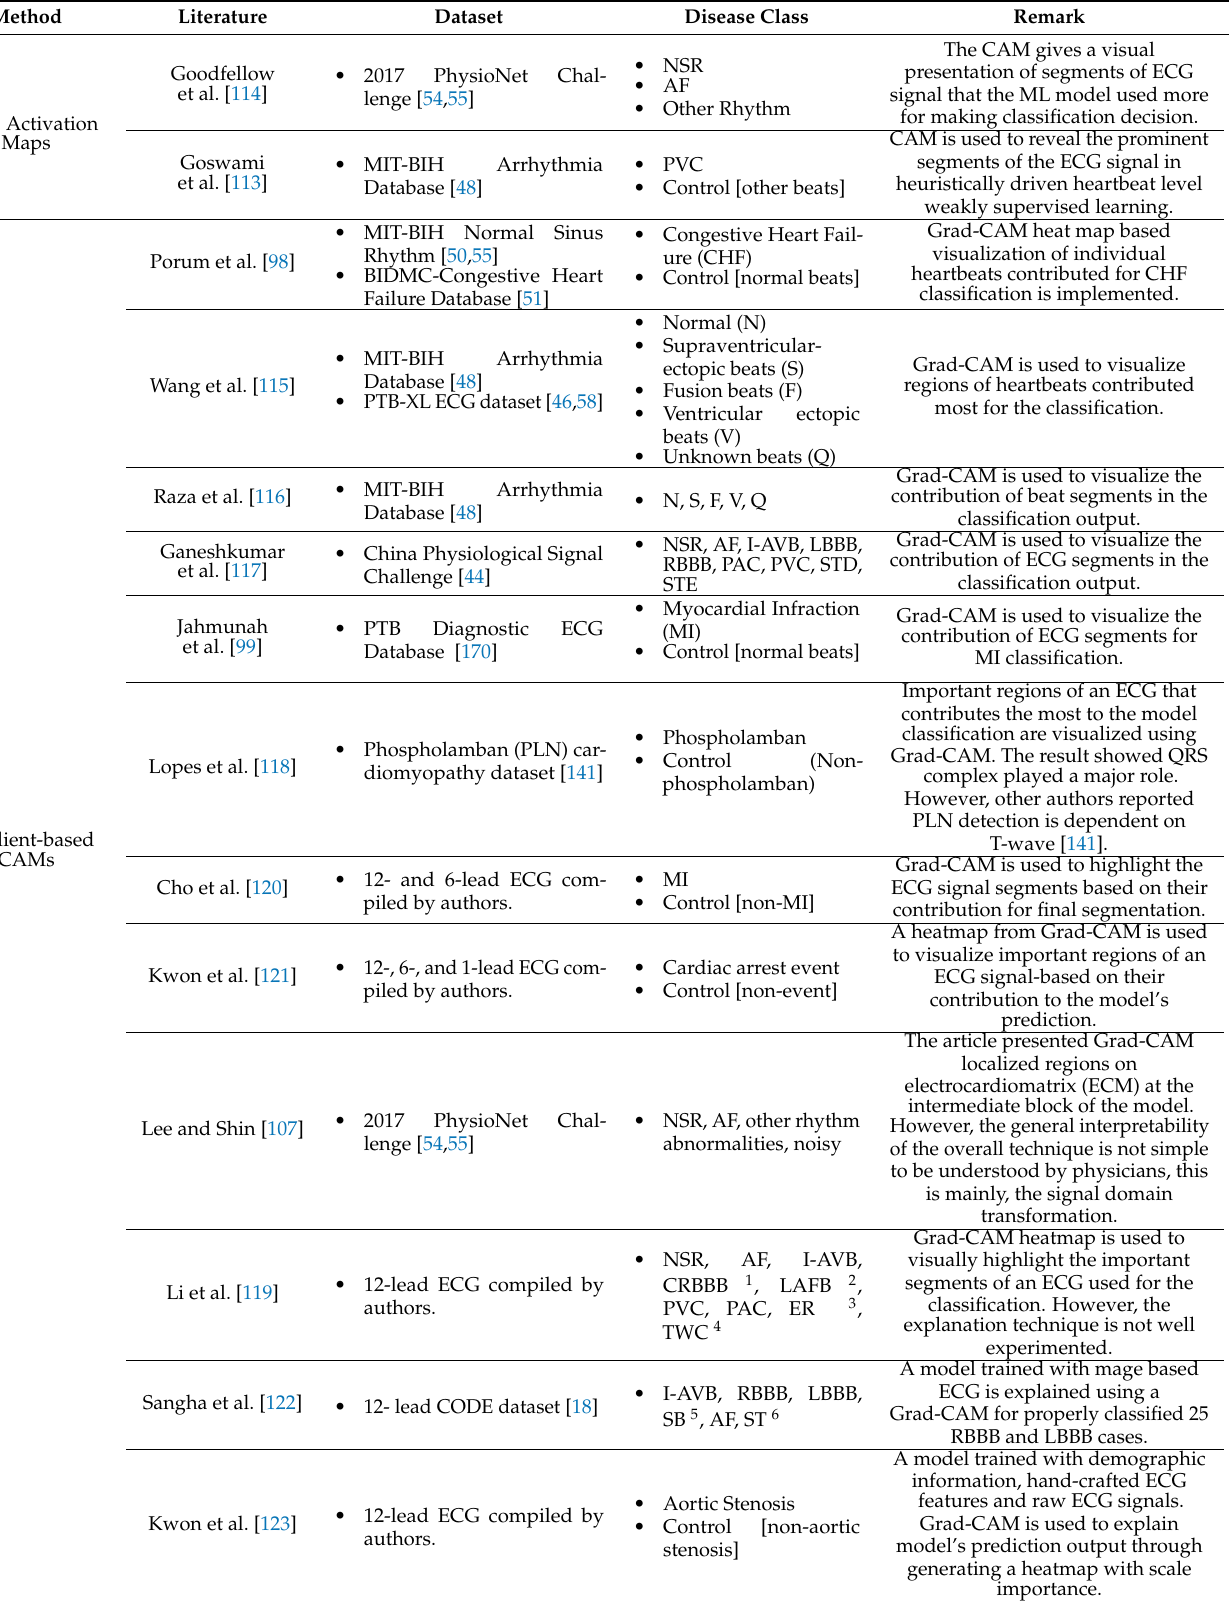
Table 8. Class activation maps based visual observation based IML techniques performance